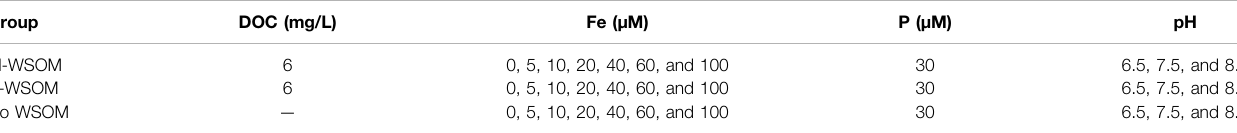
TABLE 1 | Conditions of coprecipitation of DOM, Fe, and